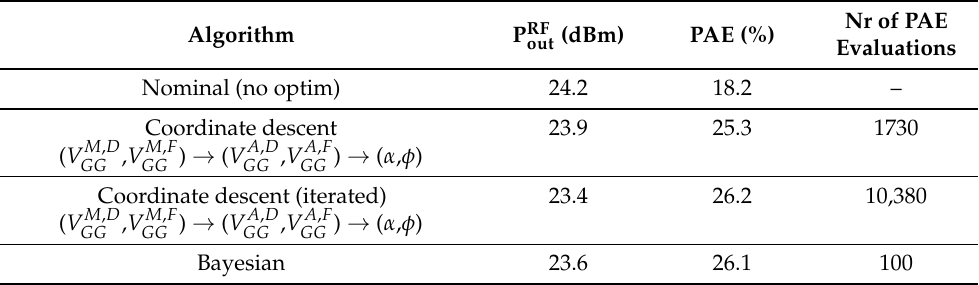
Table 4. Comparison among nominal and optimum DIDPA performance obtained by applying the various single-objective optimization algorithms to the quasi-static SUMO for PAE maximization. All optimized performances involve the ILC-based analytical linearization of the quasi-static SUMO during the